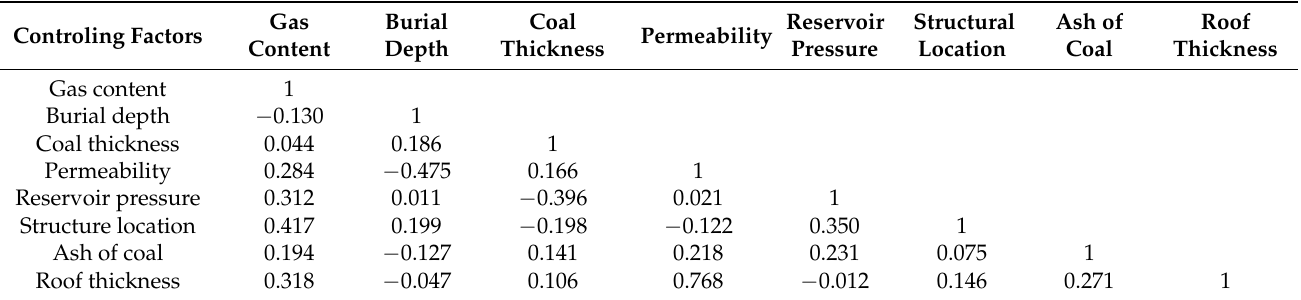
Table 6. Correlation coefficient of main controlling factor.